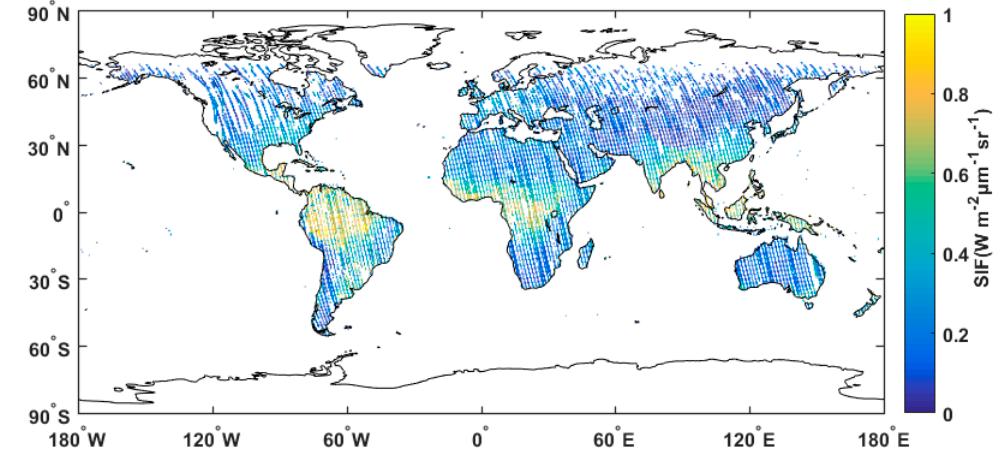
Figure 9. The spatial coverage of the OCO-2 satellite in October 2014; the color of the footprint indicates the magnitude of the chlorophyll fluorescence value, yellow indicates a high value and blue indicates a low value.